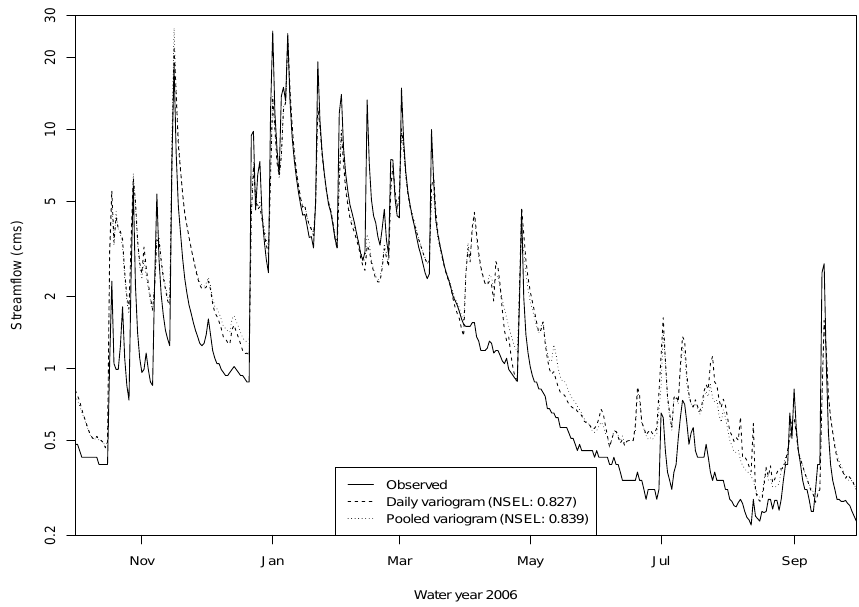
Figure 2. An example of the observed and simulated streamflows for a site and year selected to represent the median performance. The results are from site 02401390, with a drainage area of 365km 2 . Streamflow values are reported in cubic meters per second